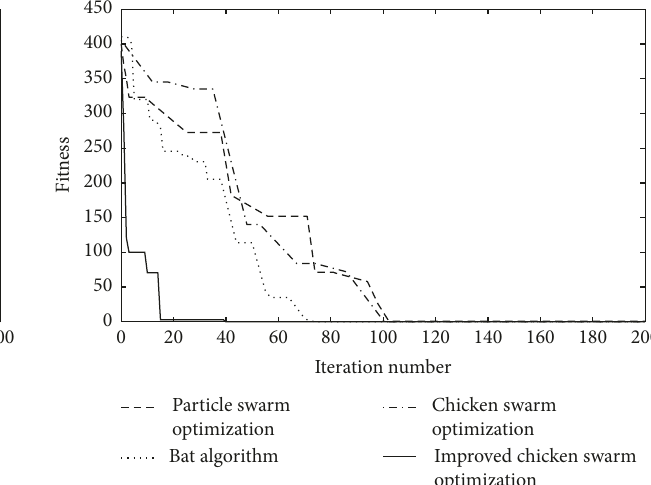
Figure 2: The experimental result of f